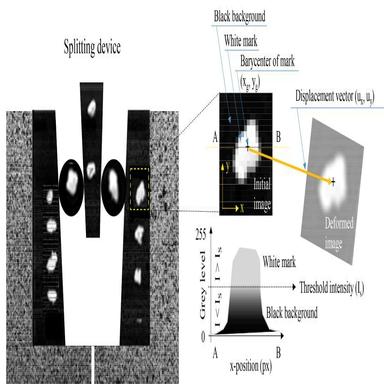
Principle of Mark Tracking (MT) method applied for displacement monitoring of metallic loading parts.